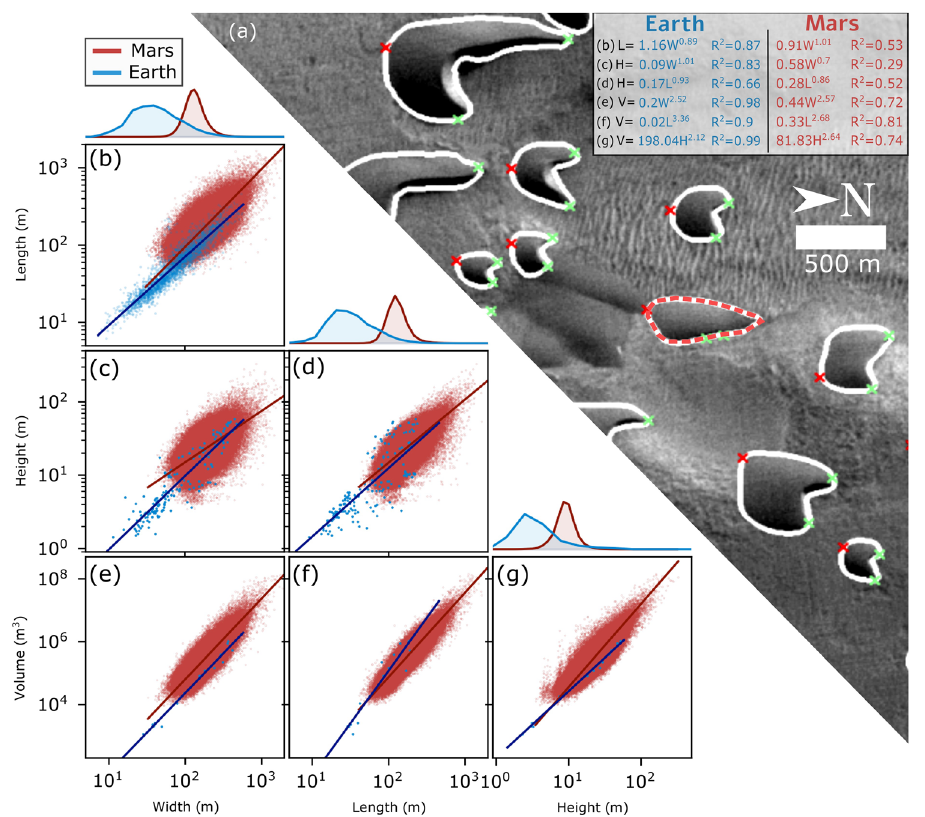
Fig. 2 | Morphometrics of barchan dunes on Mars. a Example of automatically detected barchans on Mars ( − 42.20°N, − 31.89°E). Outlines (white) were identi fi ed by the neural network in Mars Reconnaissance Orbiter (MRO) Context Camera (CTX) 42 images. The red dashed outline shows a detection that was discarded by our algorithm on the basis of the absence of a convexity deffect. Red and green